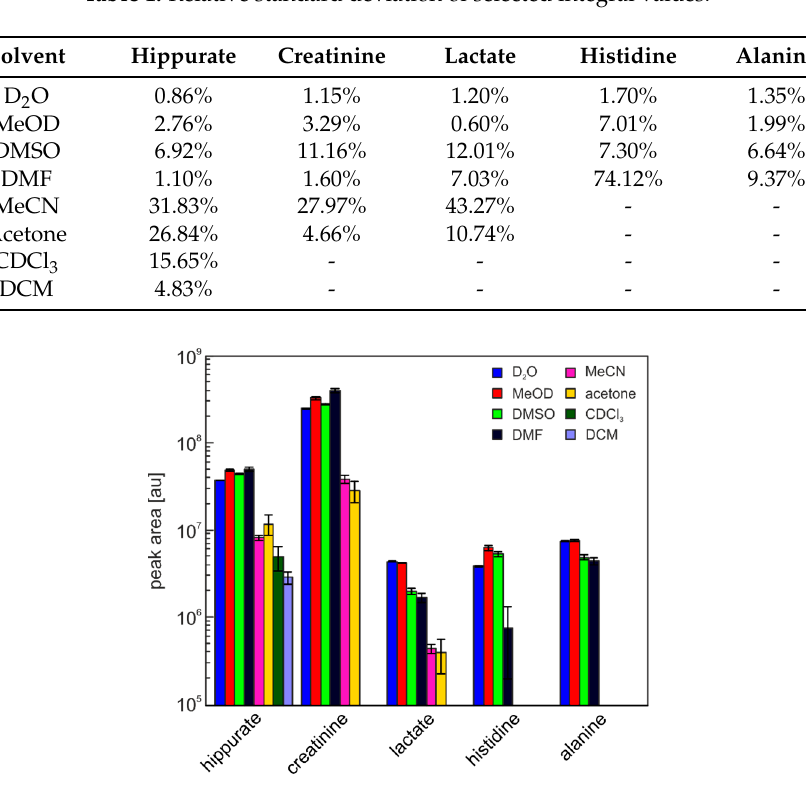
Figure 2. Mean integrals with standard deviations for the selected metabolites.